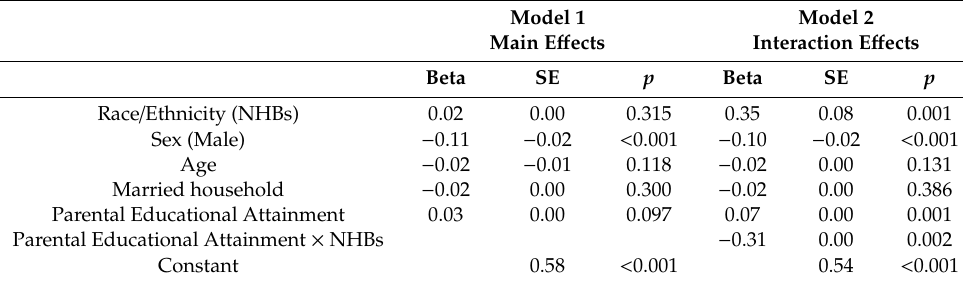
Table 4. Summary of linear regressions overall ( n =